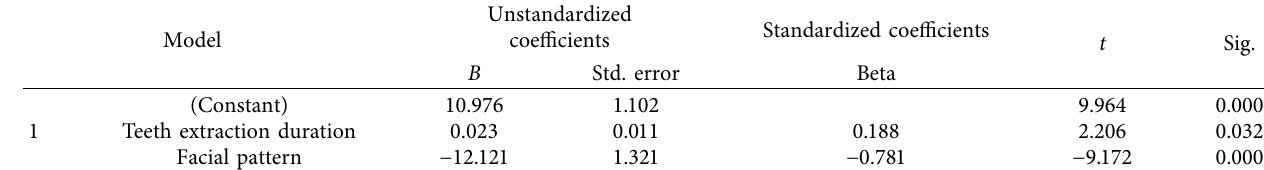
Table 7: The linear regression analysis for variables.